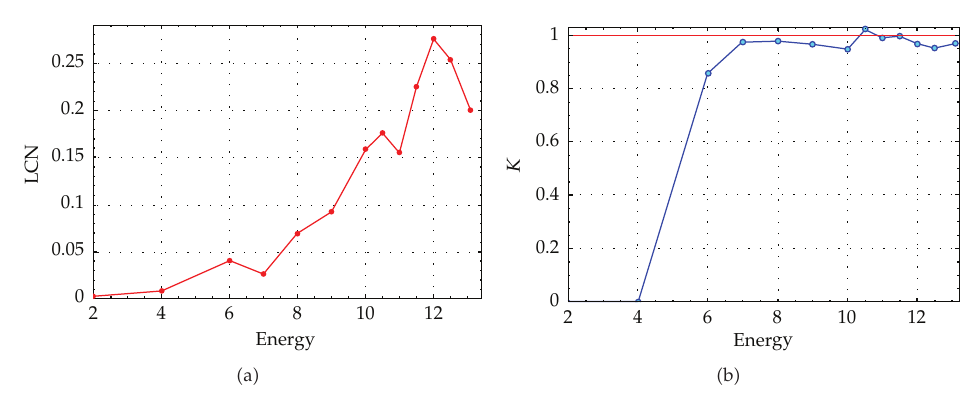
Figure 6: (cid:5) a (cid:6) LCN versus Energy in 19th-order Hamiltonian, (cid:5) b (cid:6) Index K versus Energy in the 19th-order Hamiltonian. There is conformity of both curves, but the onset of strong chaos appears abruptly at E (cid:7) 6 and is better shown in (cid:5) b (cid:6)